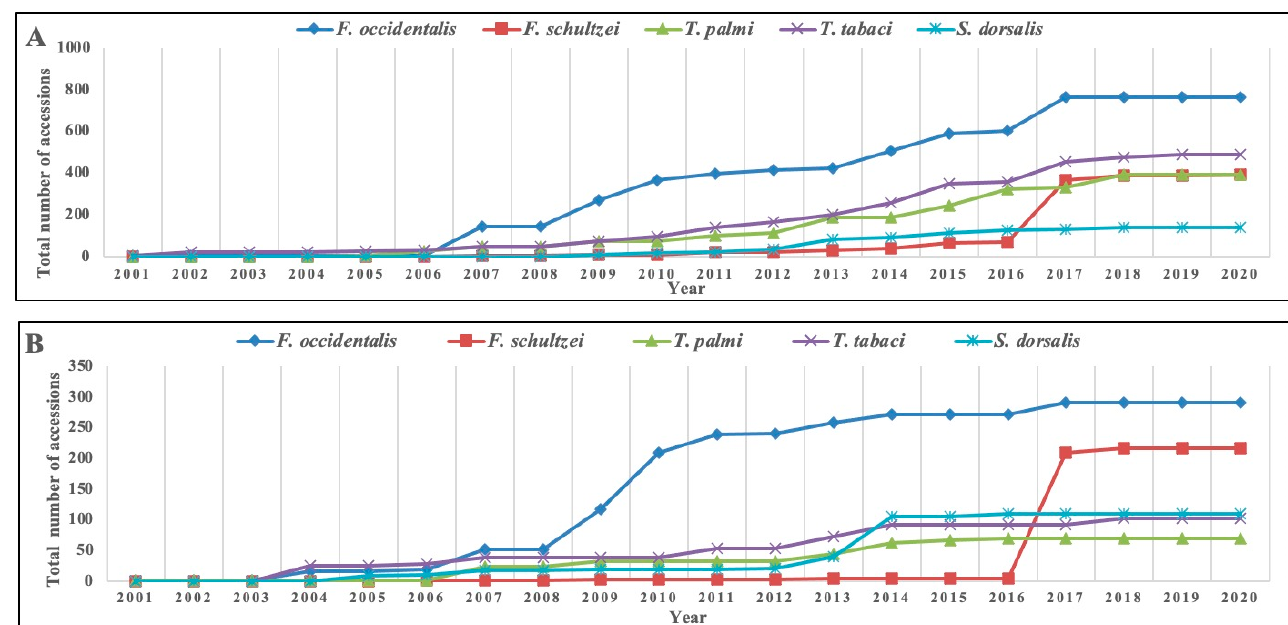
Figure 2. Trend of sequence availability for important thrips species in the NCBI database. ( A ) COI and ( B ) rRNA-ITS sequence accessions. Sequence accessions for five important thrips species, viz., Frankliniella occidentalis , F. schultzei , Scirtothrips dorsalis, Thrips palmi , and T. tabaci deposited in the NCBI database were considered. Unverified accessions were removed, and data were processed according to the year of submission. Vertical axis shows the total number of accessions, and horizontal axis represents the year of submission. COI, mitochondrial cytochrome oxidase subunit I; rRNA, ribosomal RNA; ITS, internal transcribed spacer.